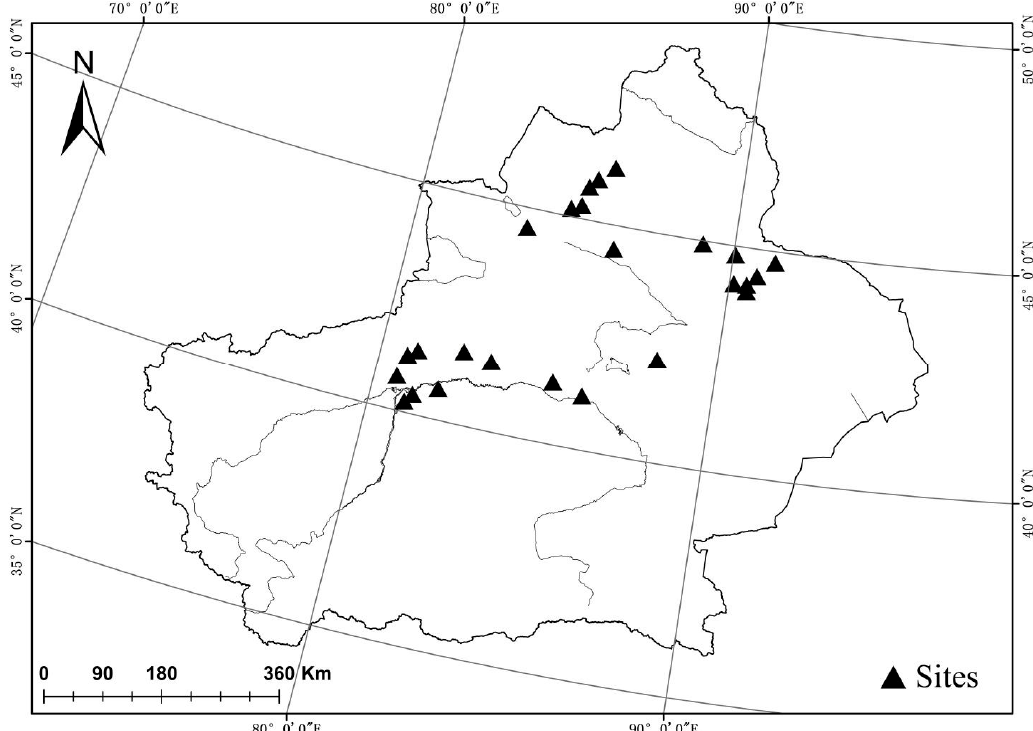
Figure 1. Locations of the 29 sampling sites in Xinjiang, China.